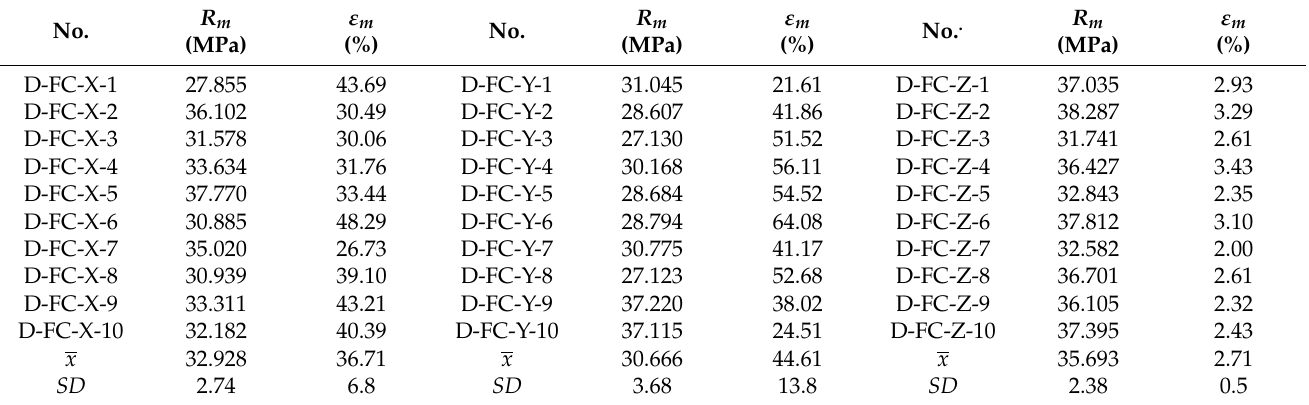
Table 1. Ultimate tensile strength and the maximum percentage strain for the FullCure 720 specimens.